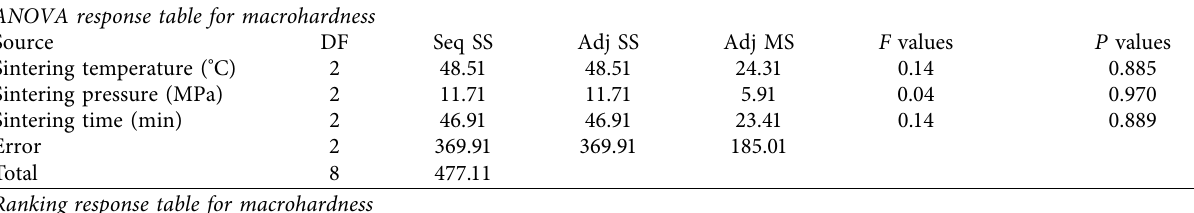
Table 6: ANOVA analysis for the mean of macrohardness. ANOVA response table for macrohardness